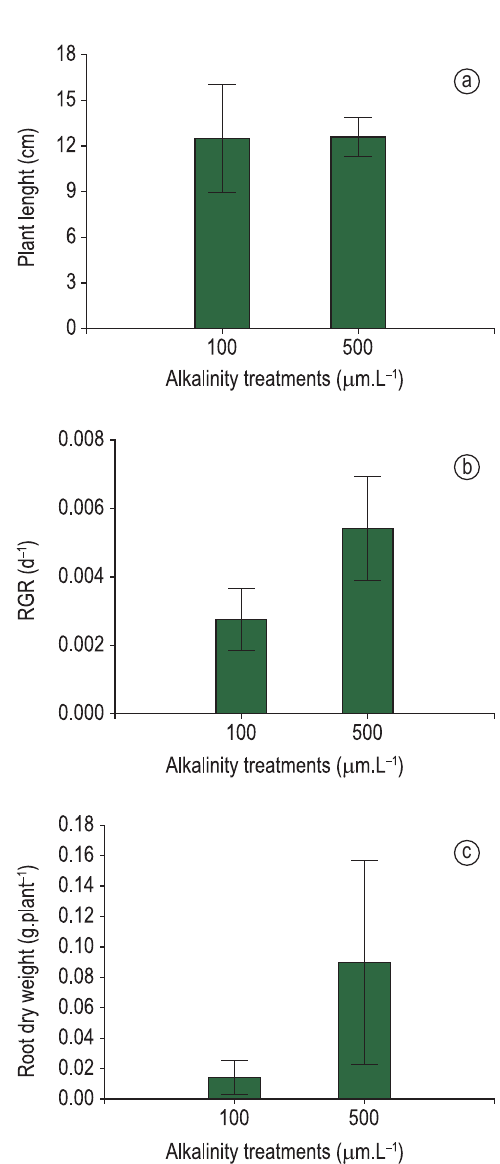
Figure 1. Mean values (± SD) of Egeria najas length (a), above-ground relative growth rates (b) and root dry weight (c) after 14 days growing in low (100 µM.L -1 ) and high (500 µM.L -1 )